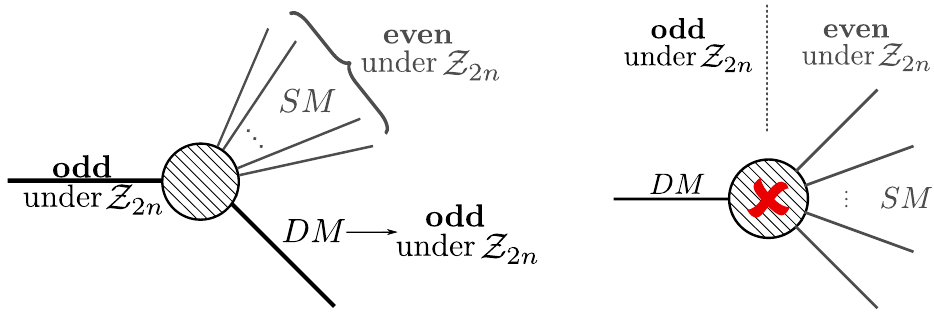
Figure 14 . When the Standard Model (cid:12)elds transform as an even power of the group any odd particle will be automatically part of the dark